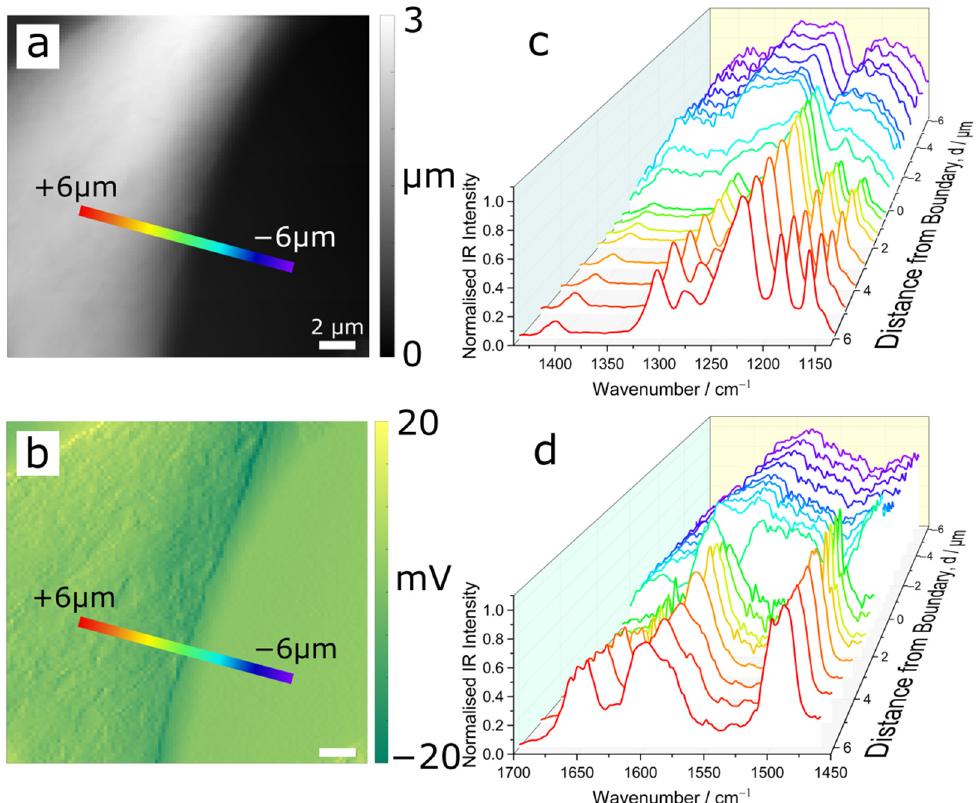
Figure 3. AFM-IR analysis traversing a PPB domain boundary, ‘low’ domain to the right, ‘high’ to the left. ( a ) AFM topography map, ( b ) AFM vertical deflection map, ( c ) AFM-IR spectra in the 1134–1440 cm − 1 region, and ( d ) AFM-IR spectra in the 1460–1700 cm − 1 region. The spectra were recorded at the positions shown in the maps in ( a , b ), where the ‘edge’ was determined from the vertical deflection plot ( b ) and negative distances correspond to the ‘low’ PBI domain side of the boundary. Spectra in the waterfall plots are normalised within each spectral region—i.e., dividing by the maximum intensity. The individual spectra are shown in Appendix A Figure A3.